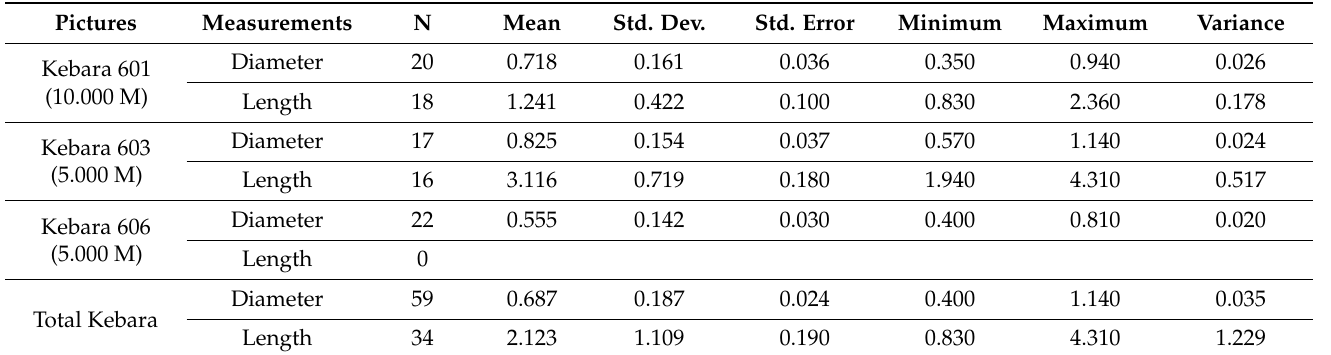
Table 2. The measurements in µ m (diameter and length) of the Kebara 2 tartar bacteria, taken from the indicated SEM pictures.